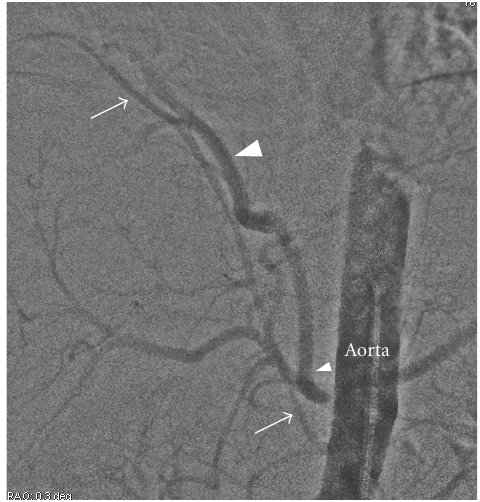
Figure 7: Intra-arterial digital subtraction angiogram reveals two anomalous arteries originating from abdominal aorta (arrow and arrow head).